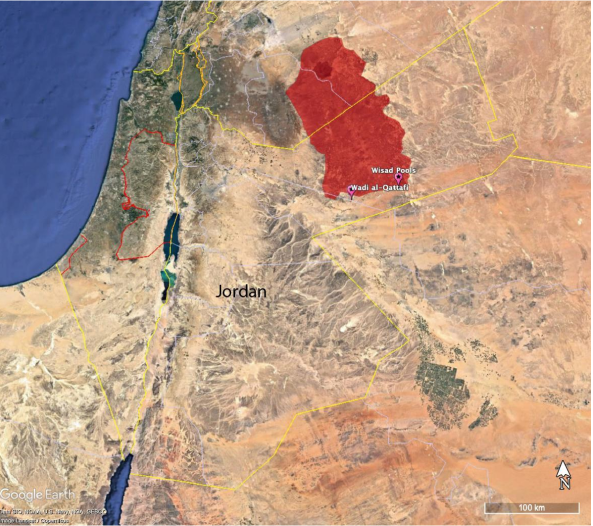
Figure 1. Location of Wadi al-Qattafi. The harra region is indicated in red. Depositional basins in the region, known locally as qa’ (qe’an, plural), hold water for short periods of time after winter rains. These qe’an would not only attract people, but also the animals they hunted. Wadi al-Qattafi is a drainage system with three arms that merge about five km north of Qa’ al-Qattafi, an area of about 10 sq. km 2 in area. This drainage continues to the south approximately 10 km before emptying into a plain about 40 km southeast of Azraq. Directly to the north of the qa’, only a few isolated hunting or pastoral camps and burin sites are known